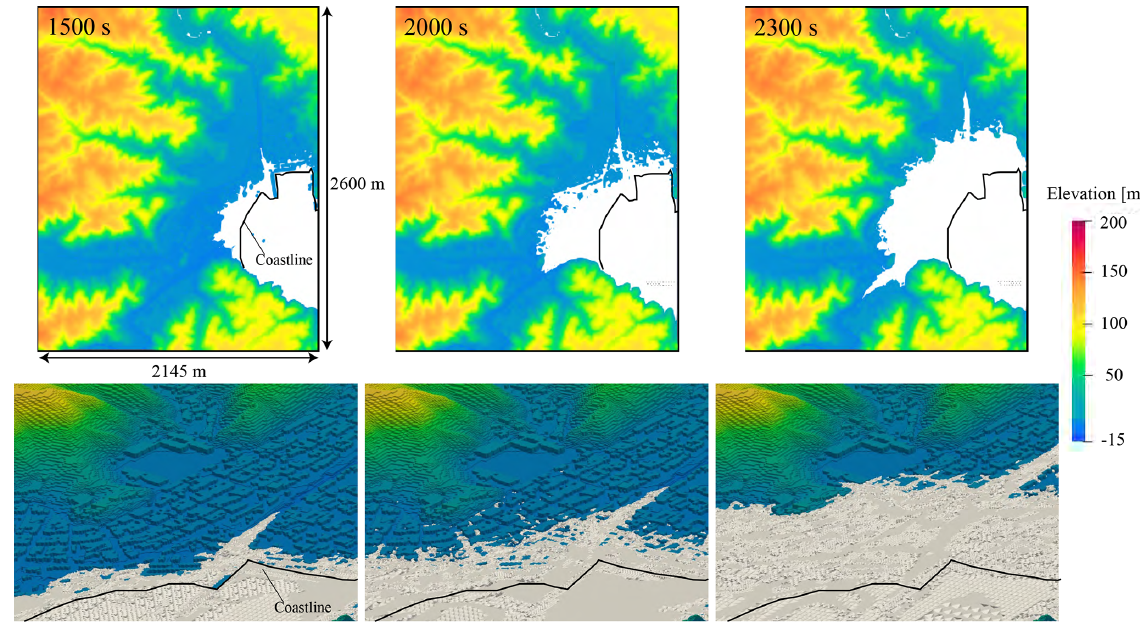
Figure 8. Snapshots of tsunami run-up obtained in 3D analysis. The white-colored area represents the inundation area.